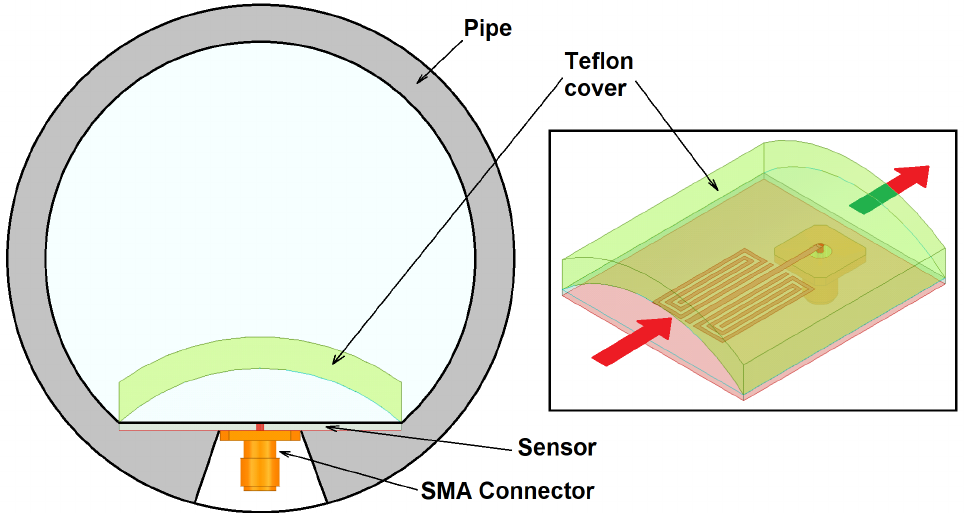
Figure 4. Integration of the sensor inside of a pipe (gray). A Teflon cover is placed above the sensor for ensuring an axial flow near the SRR resonator. Only part of the fluid (blue) contributes to the measurement. For obtaining a relevant sample, a homogeneous flow must be achieved. The inset shows a 3D view of the cover and the